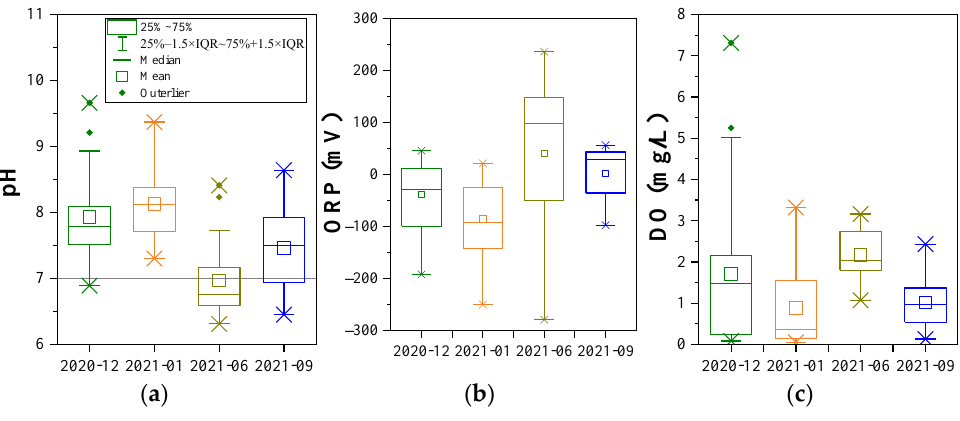
Figure 7. Variation of pH ( a ), ORP ( b ), and DO ( c ) of groundwater.